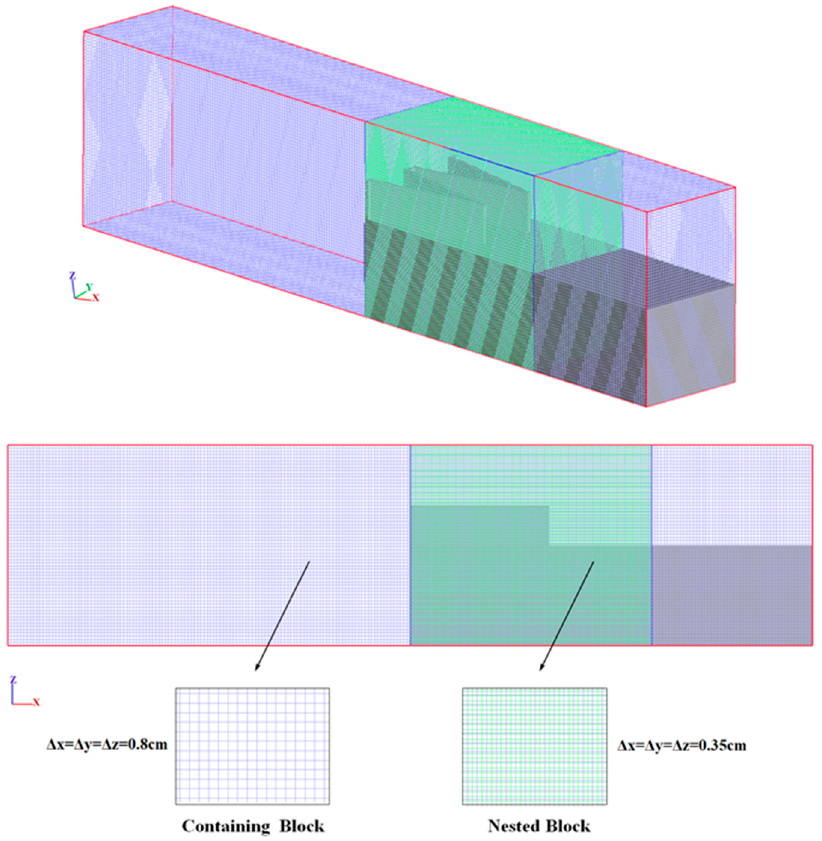
Figure 3. Sketch of mesh setup.